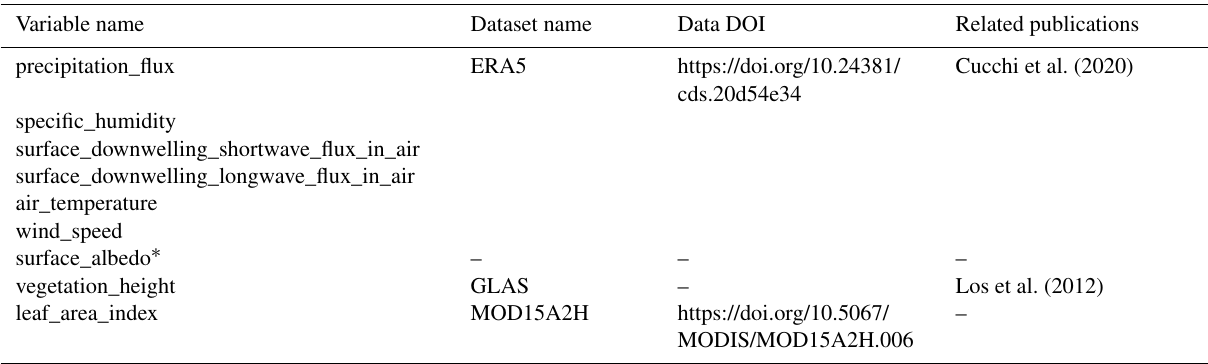
Table A3. Sources for data used in configuration